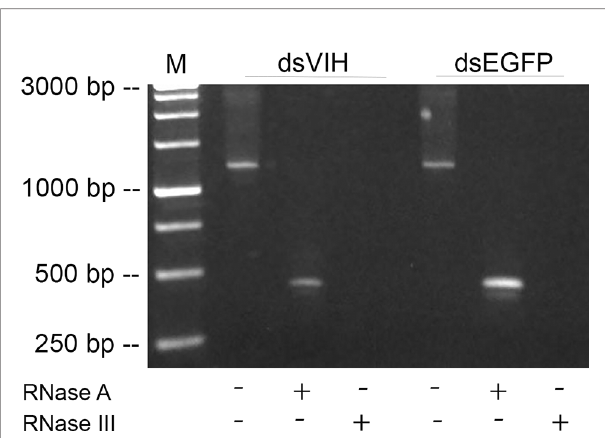
FIGURE 1 | Visualization of the dsRNA production. Lane M was the 3kb DNA ladder marker. Lanes 1 and 4 were shown approximately 1200 bp of non-digested dsRNA-VIH and dsRNA-EGFP. Lanes 2 and 5 were shown approximately 600 bp of RNase A-digested dsRNA-VIH and dsRNA-EGFP. Lanes 3 and 6 were the RNase III-digested dsRNA-VIH and dsRNA-EGFP revealed no product